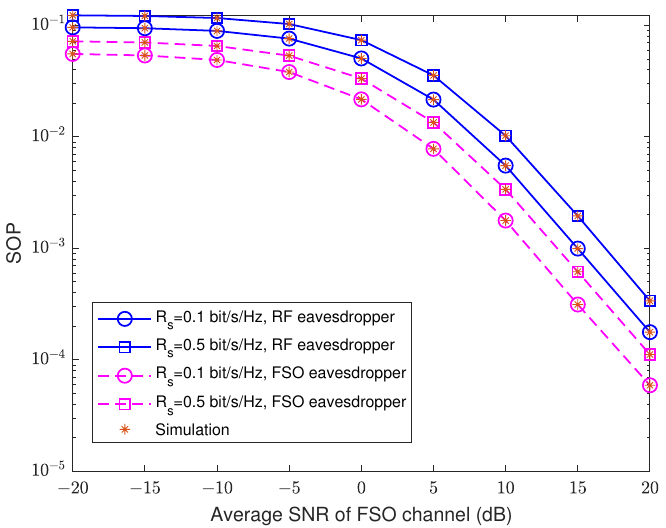
Figure 8. Under different R s conditions, the relationship between the SOP of the hybrid system with RF and FSO link eavesdropping and the average SNR of the FSO